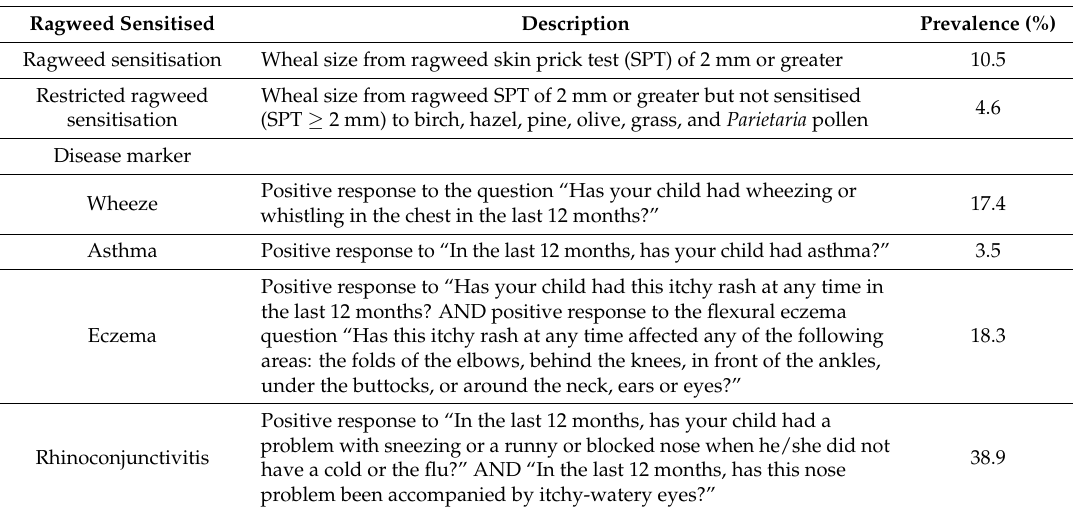
Table 1. Dependent variables of interest used in the